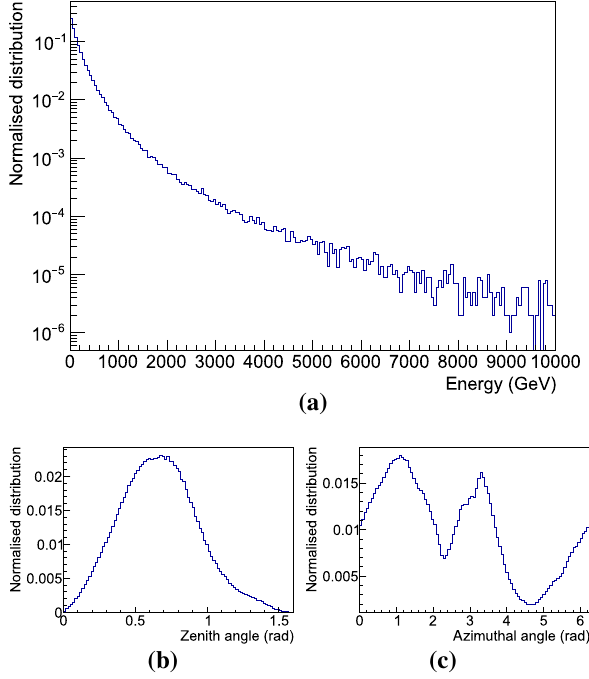
Fig. 7 Spectrum of the (a) energy, (b) zenith angle and (c) azimuthal angle of muons reaching the LNGS underground laboratory, obtained using the MUSUN [26] simulation